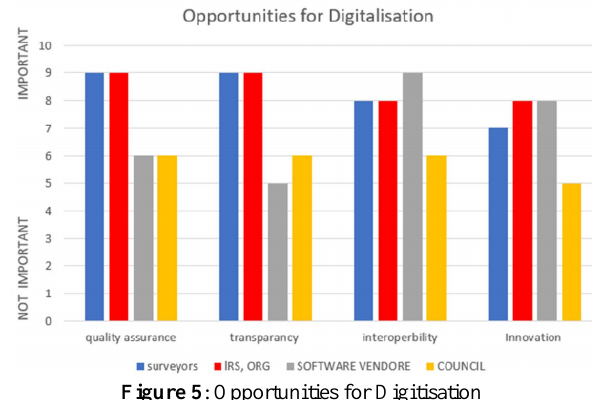
Figure 7: Strata Plan TIFF